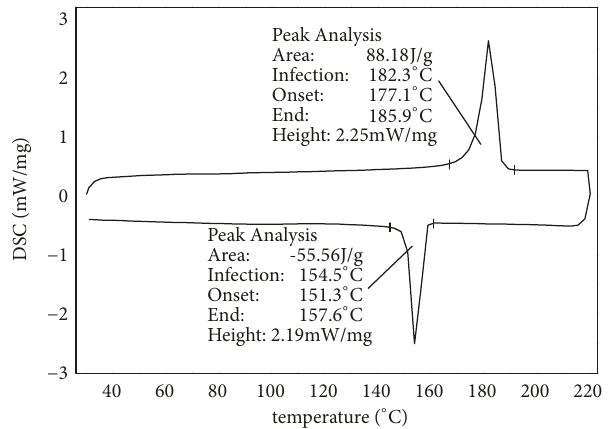
Figure 6: DSC result of PP powders.